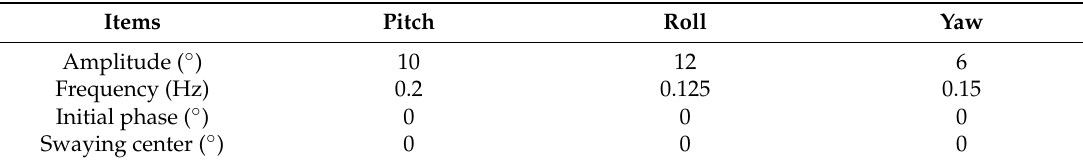
Table 2. The swaying